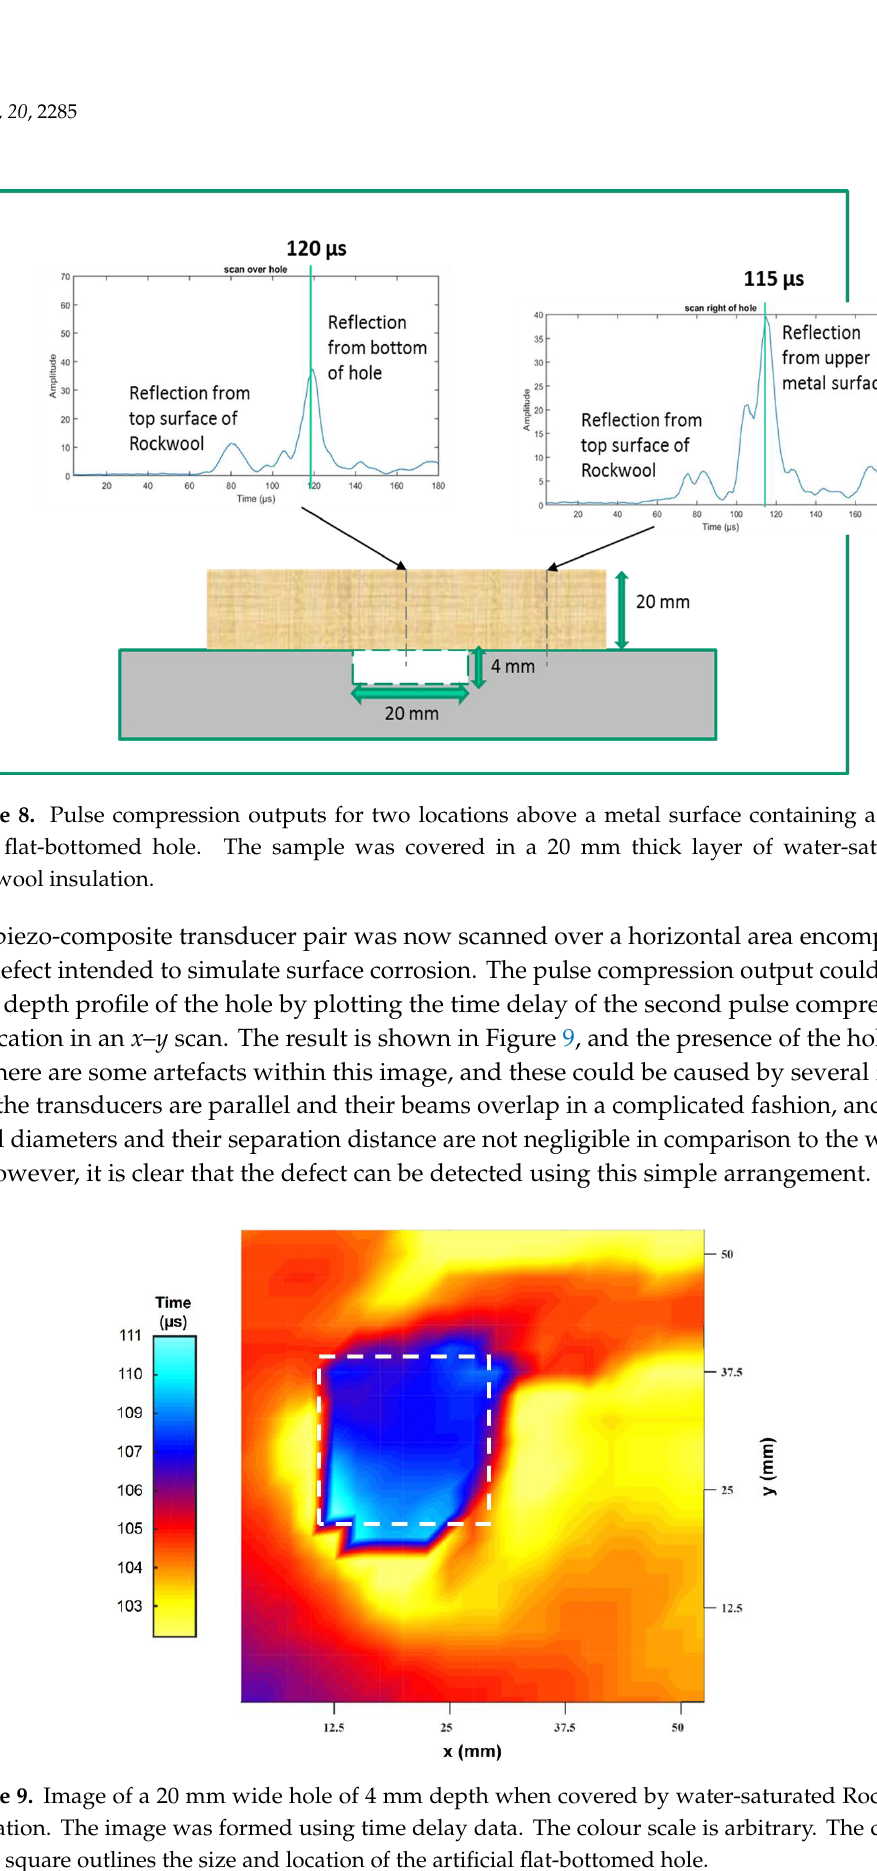
Figure 9. Image of a 20 mm wide hole of 4 mm depth when covered by water-saturated Rockwool insulation. The image was formed using time delay data. The colour scale is arbitrary. The dashed white square outlines the size and location of the artificial flat-bottomed hole.